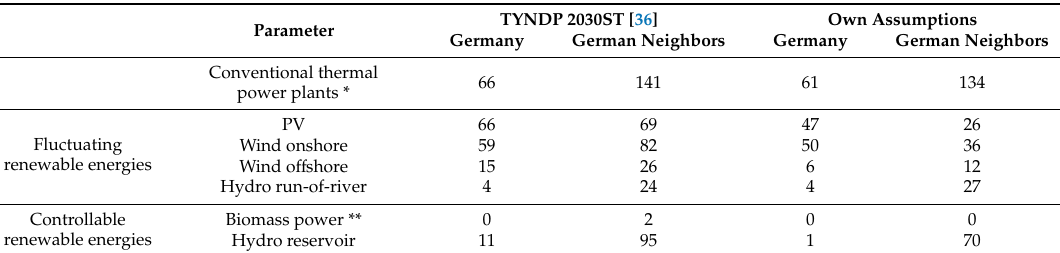
Table A2. Quantitative assumptions for the existing power supply capacities as an input for the scenario study runs, aggregated for Germany and its neighboring countries. Pumped hydro power is not shown. All values in GW.